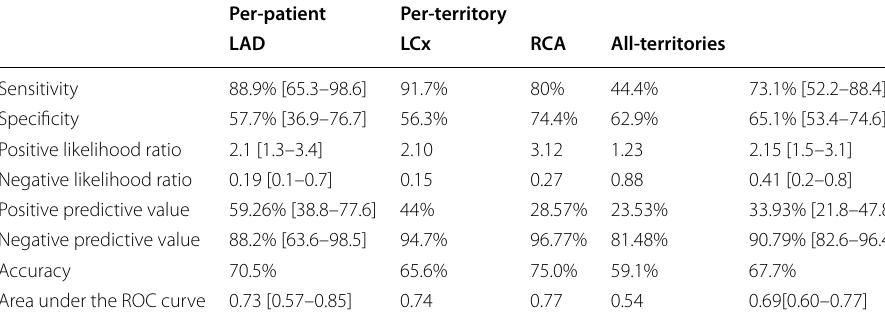
Table 3 Diagnostic performance of CT-MPI on a per patient and per-territory analysis using 82 Rb PET-MPI as the reference standard